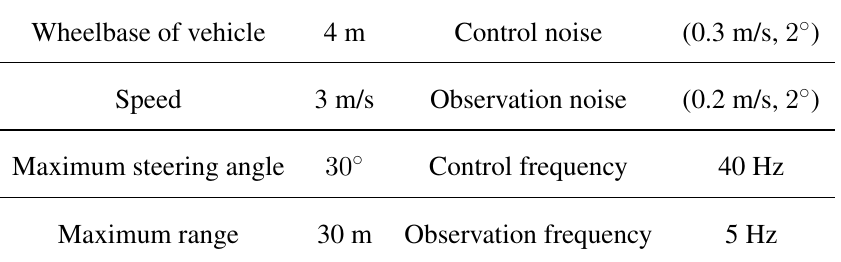
Table 1. Basic parameters set in the simulation.